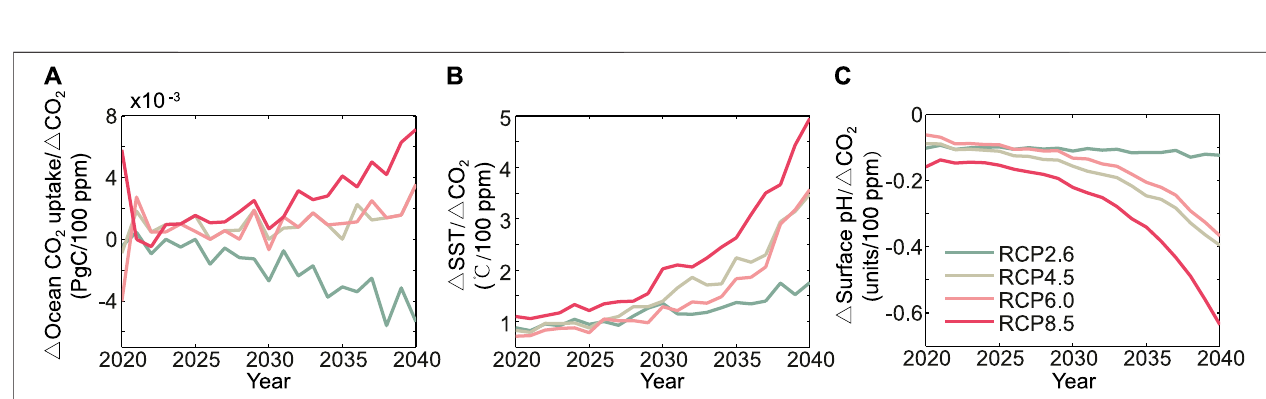
Frontiers in Physics |